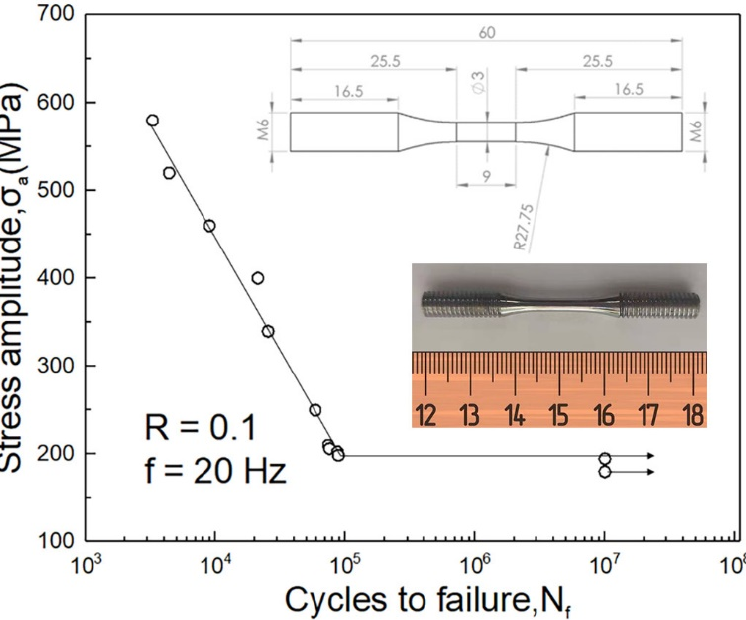
Figure 1. S-N Curve of the Zr 61 Ti 2 Cu 25 Al 12 glass at an R ratio of 0.1 and a frequency of 20 Hz. The fatigue limit of the glass is 195 MPa. The insets show the mechanical drawing and a photograph of the test specimens.